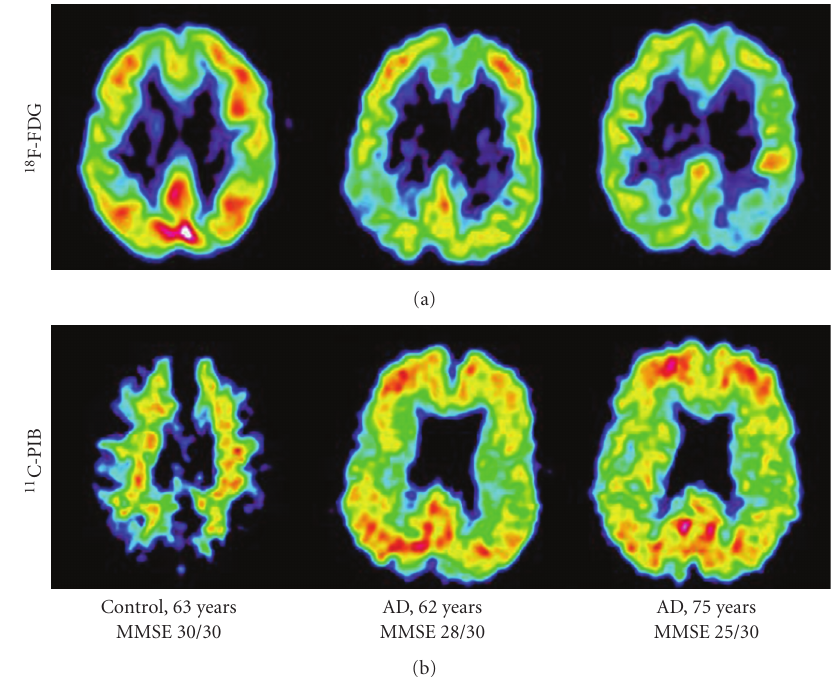
Figure 2: Cerebral glucose metabolism ( 18 F-FDG) and 11 C-PIB amyloid imaging in two AD patients and one healthy control. The PET scans show 18 F-FDG and 11 C-PIB at a sagittal section. MMSE: Mini Mental State Examination. Adapted from